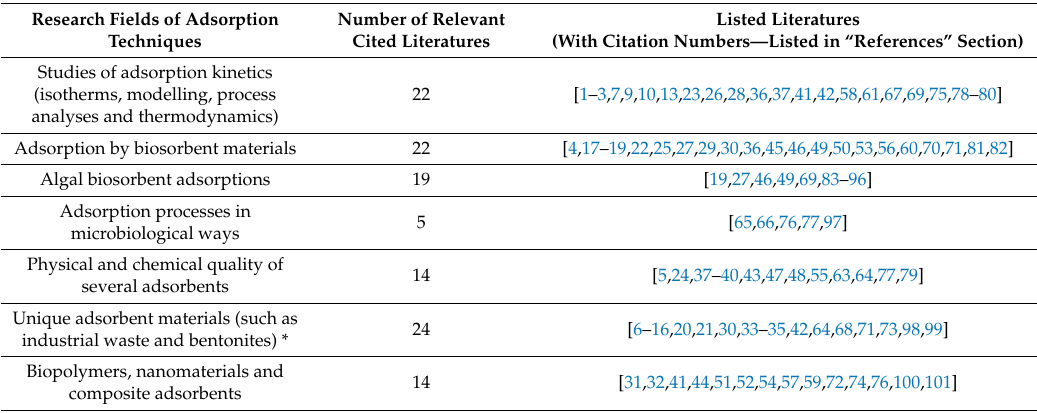
Table 1. Listed literatures grouped by adsorption research fields (edited by